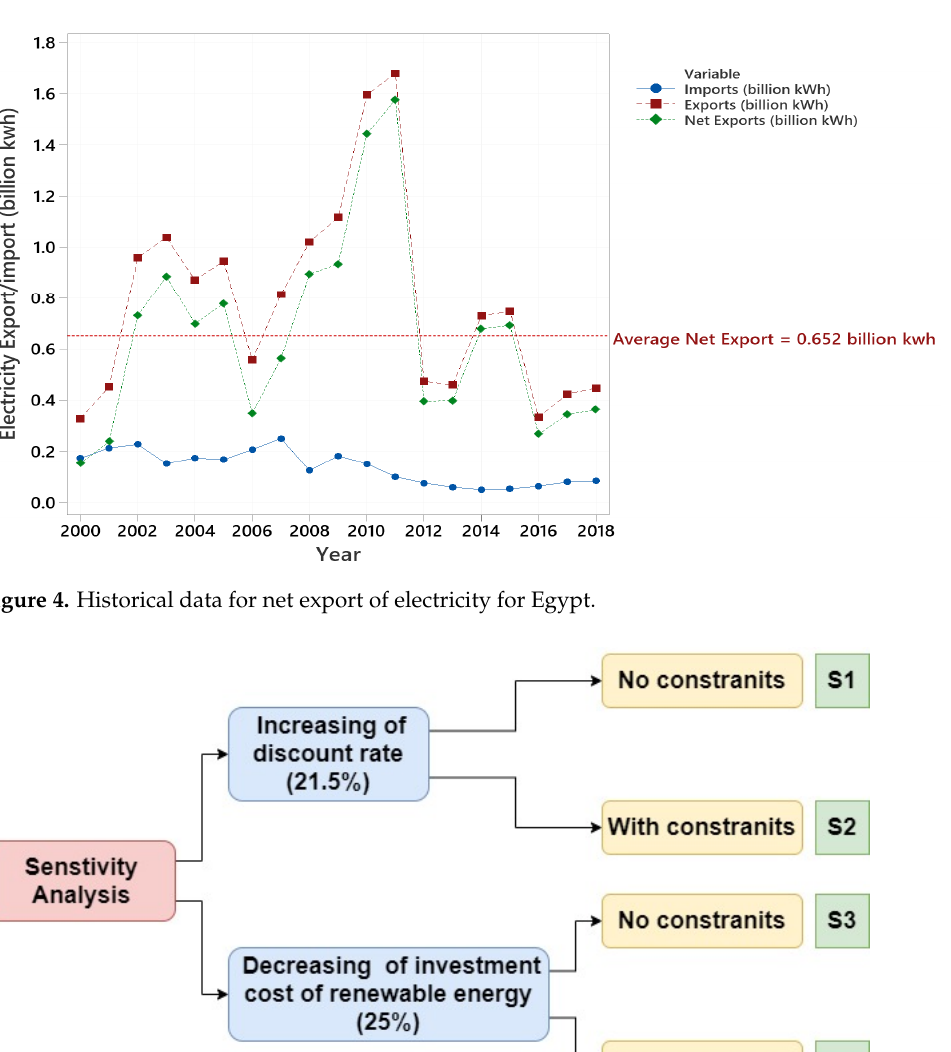
Figure 4. Historical data for net export of electricity for Egypt.